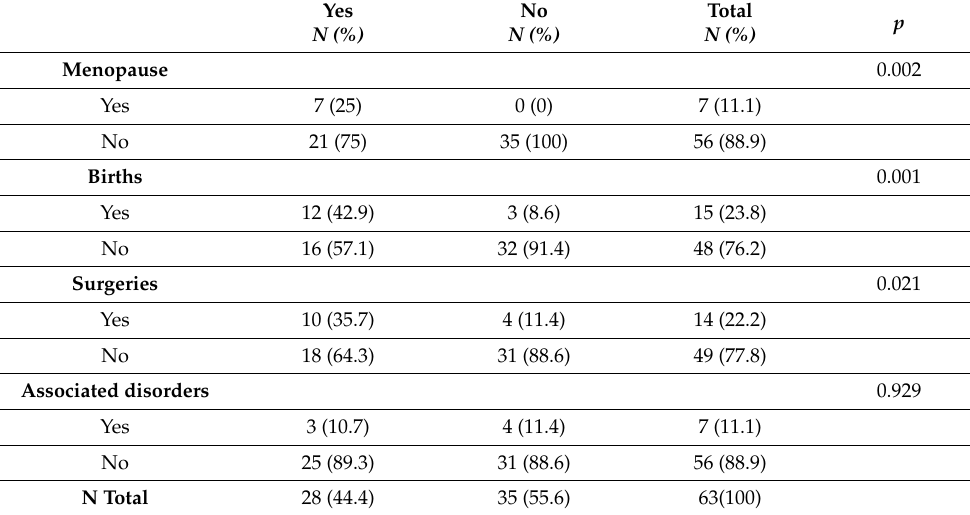
Table 2. UI and risk